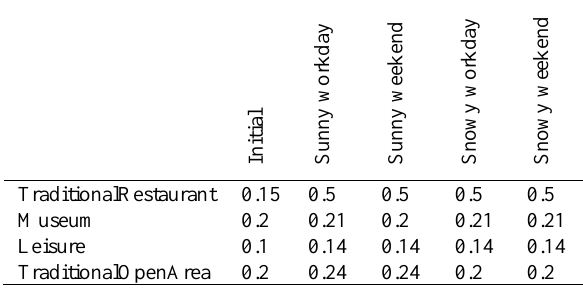
Table 1. Computed preference values of TraditionalRestaurant,